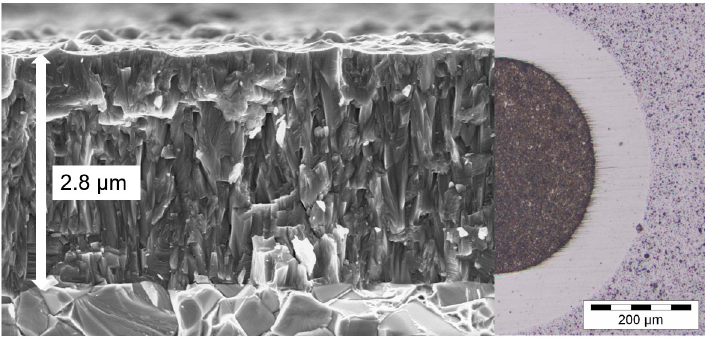
Figure 26. Cross-section and calotte of an industrially applied arc coating, BALINIT ® ALCRONA PRO, courtesy of Oerlikon Balzers.